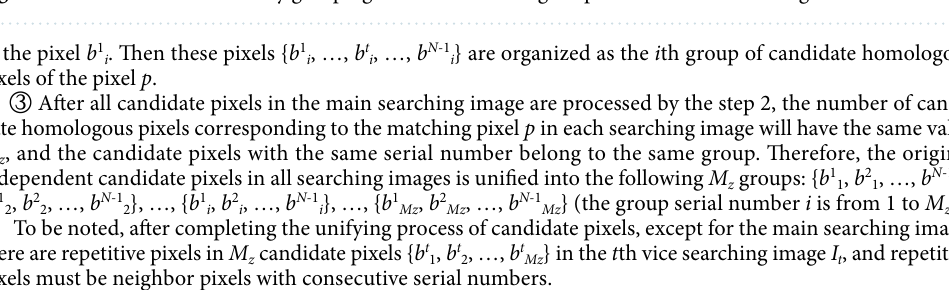
Figure 5. The sketch of uniformly grouping candidate homologous pixels in multi-view